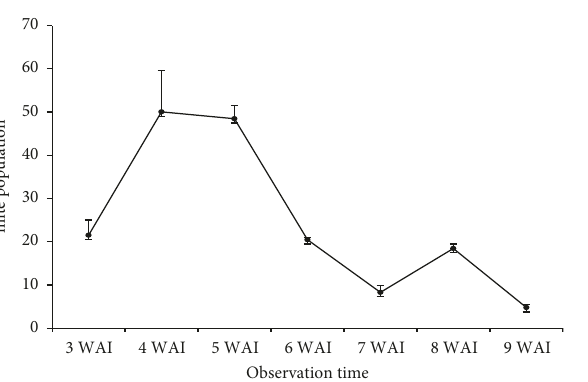
Figure 2: Total of mite population ( ± SE) at some observation times, glass house of ILETRI, 2018; WAI � weeks after